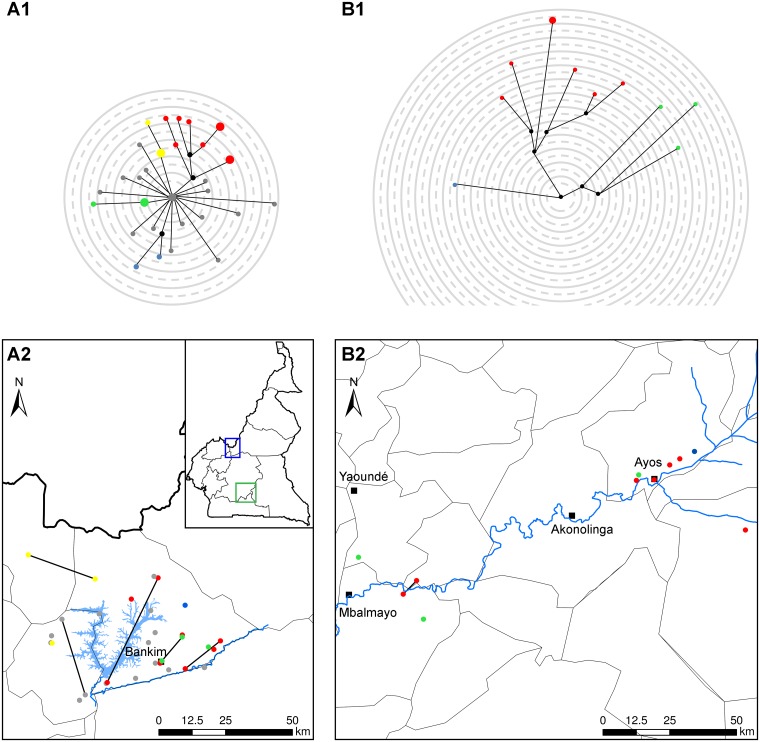
Phylogeographic analysis of M. ulcerans in the Mapé and Nyong river basins of Cameroon.Detailed information about the places of residence of the patients for the year before the onset of BU disease was collected from all patients from whom M. ulcerans was isolated. Micro-evolutionary diversity of M. ulcerans at the two BU endemic sites is shown in panel A1 (Mapé river basin) and panel B1 (Nyong river basin). Median joining networks using 117 variable single nucleotide positions among whole genome sequences of M. ulcerans isolates from the Mapé river basin and 107 positions in isolates from the Nyong river basin area are depicted. Branch lengths correspond to the number of SNP differences, circle sizes correspond to the number of isolates and circle colours correspond to the sub-clusters defined. Black circles indicate median vectors (mv) and are hypothetical genotypes. Panels A2 (Mapé river basin) and B2 (Nyong river basin) show the geographic localization of the patient’s residences with the locations colour coded according to the lineages shown in panel A1 and B1. When isolates of two patients were exactly the same, the respective homes of the patients are connected by a line. Major towns in the areas are indicated by black squares.